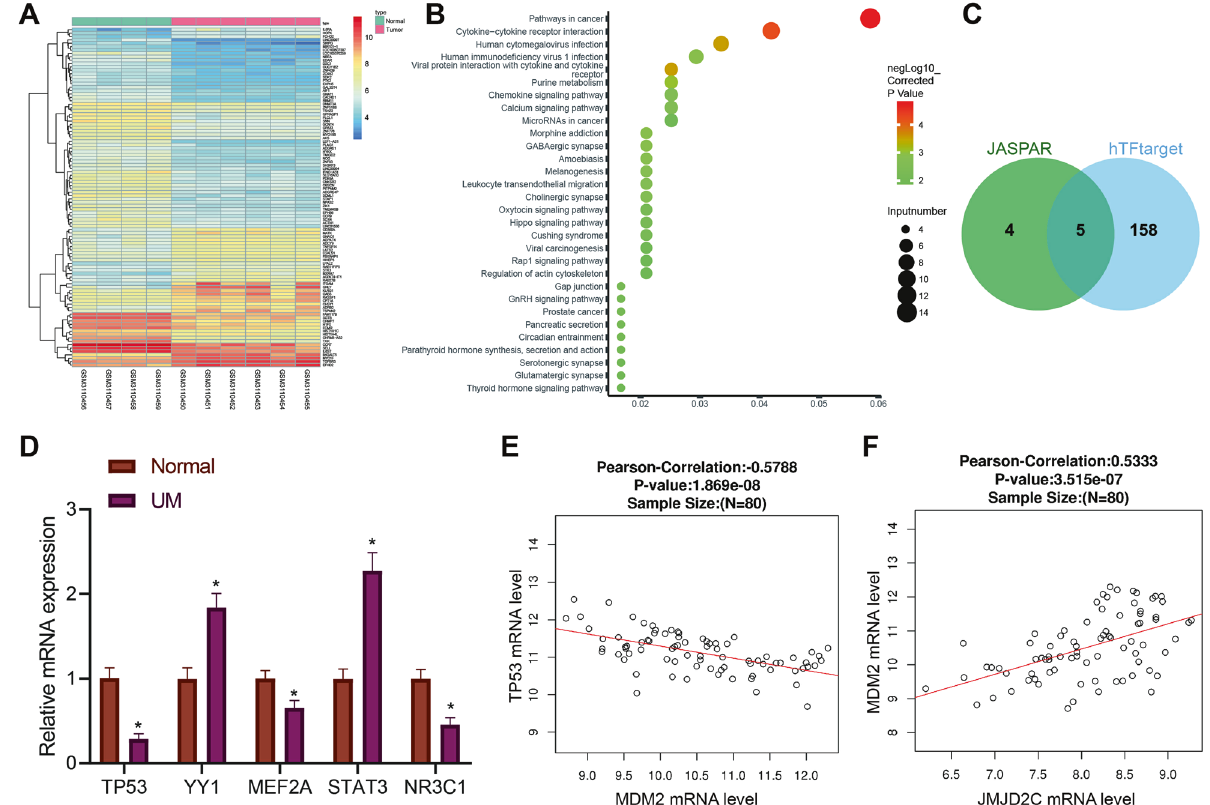
Fig. 1 Possible molecular targets involved in the occurrence and development of uveal melanoma are screened by bioinformatics analysis. A The heatmap for differential gene expression in GSE113625 uveal melanoma dataset. X -axis represents sample number, Y -axis represents gene name, left dendrogram represents gene expression clustering, each small block in the fi gure represents the expression of a gene in a sample, and the upper right histogram is color scale. B KEGG pathway enrichment analysis of differentially expressed genes. X -axis represents GeneRatio, the Y -axis represents KEGG entry, the circle color represents the corrected enrichment p value, the size represents the number of genes enriched in the entry, and the right histogram is the color scale. C IL5RA upstream transcription factor prediction. Two circles in the fi gure represent the prediction results of JASPAR database and hTFtarget database, and the middle part represents the intersection of the two groups of data. D The expression of TP53, YY1, MEF2A, STAT3, and NR3C1 in uveal melanoma ( n = 32) and normal controls ( n = 30) determined by RT-qPCR. * p < 0.05. E Correlation analysis between TP53 and MDM2 mRNA expression in the uveal melanoma samples from TCGA database. The abscissa represents the expression value of MDM2, the ordinate represents the expression value of p53, and the p value the correlation and the Pearson ’ s correlation coef fi cient are presented in the top. F Correlation analysis between JMJD2C (KMD4C) and MDM2 mRNA expression in the uveal melanoma samples from TCGA database. X -axis represents JMJD2C expression value, Y -axis represents MDM2 expression value, and the p value for the correlation and Pearson ’ s correlation coef fi cient are presented in the